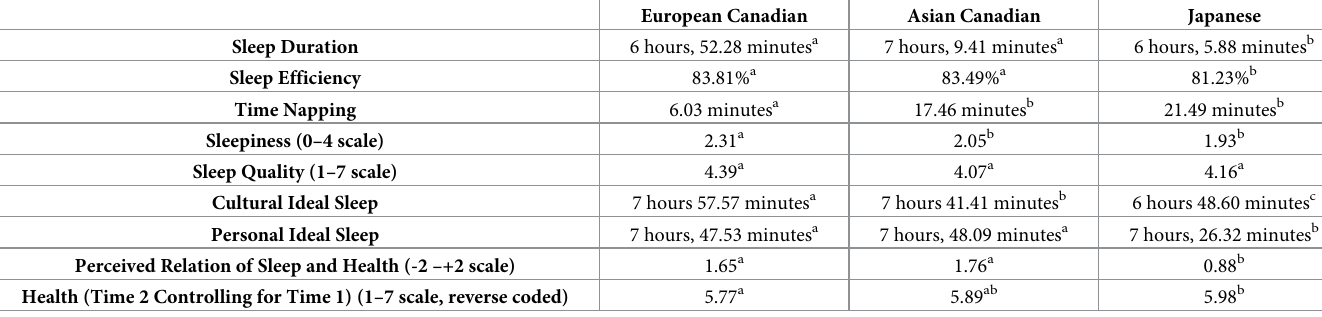
Table 1. Cultural comparisons of all dependent measures.